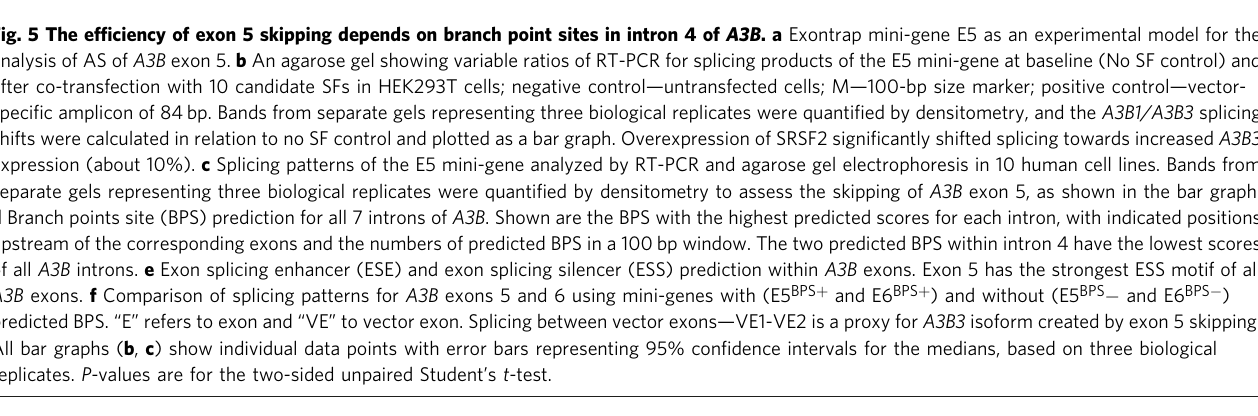
Fig. 5 The ef fi ciency of exon 5 skipping depends on branch point sites in intron 4 of A3B . a Exontrap mini-gene E5 as an experimental model for the analysis of AS of A3B exon 5. b An agarose gel showing variable ratios of RT-PCR for splicing products of the E5 mini-gene at baseline (No SF control) and after co-transfection with 10 candidate SFs in HEK293T cells; negative control — untransfected cells; M — 100-bp size marker; positive control — vector- speci fi c amplicon of 84 bp. Bands from separate gels representing three biological replicates were quanti fi ed by densitometry, and the A3B1/A3B3 splicing shifts were calculated in relation to no SF control and plotted as a bar graph. Overexpression of SRSF2 signi fi cantly shifted splicing towards increased A3B3 expression (about 10%). c Splicing patterns of the E5 mini-gene analyzed by RT-PCR and agarose gel electrophoresis in 10 human cell lines. Bands from separate gels representing three biological replicates were quanti fi ed by densitometry to assess the skipping of A3B exon 5, as shown in the bar graph. d Branch points site (BPS) prediction for all 7 introns of A3B . Shown are the BPS with the highest predicted scores for each intron, with indicated positions upstream of the corresponding exons and the numbers of predicted BPS in a 100 bp window. The two predicted BPS within intron 4 have the lowest scores of all A3B introns. e Exon splicing enhancer (ESE) and exon splicing silencer (ESS) prediction within A3B exons. Exon 5 has the strongest ESS motif of all A3B exons. f Comparison of splicing patterns for A3B exons 5 and 6 using mini-genes with (E5 BPS + and E6 BPS + ) and without (E5 BPS − and E6 BPS − ) predicted BPS. “ E ” refers to exon and “ VE ” to vector exon. Splicing between vector exons — VE1-VE2 is a proxy for A3B3 isoform created by exon 5 skipping. All bar graphs ( b , c ) show individual data points with error bars representing 95% con fi dence intervals for the medians, based on three biological replicates. P -values are for the two-sided unpaired Student ’ s